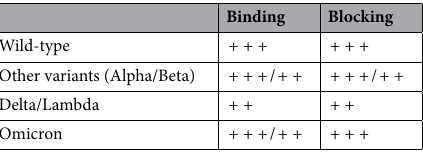
Table 1. Summary of ABS-VIR-001 potency against key variants throughout the